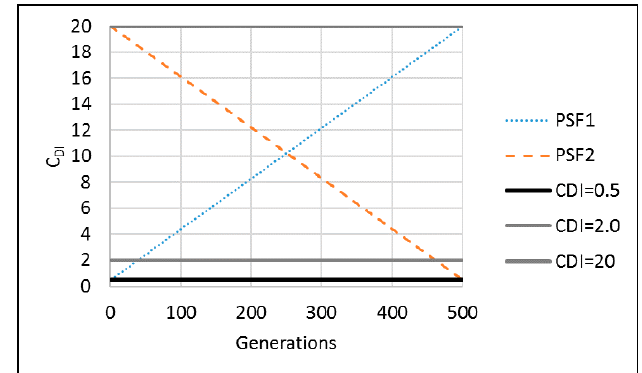
Figure 2. Changes in crossover distribution index (C DI ) using the two parameter-setting-free (PSF) methods over generations when the number of generations (NGEN) = 500.